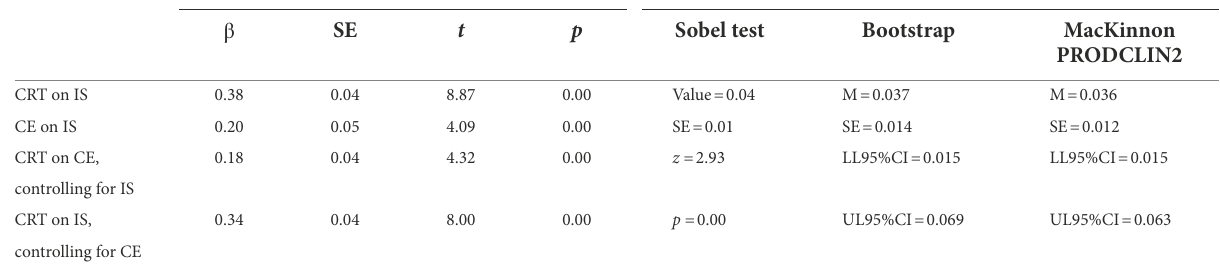
TABLE 7 The mediating effect of creative